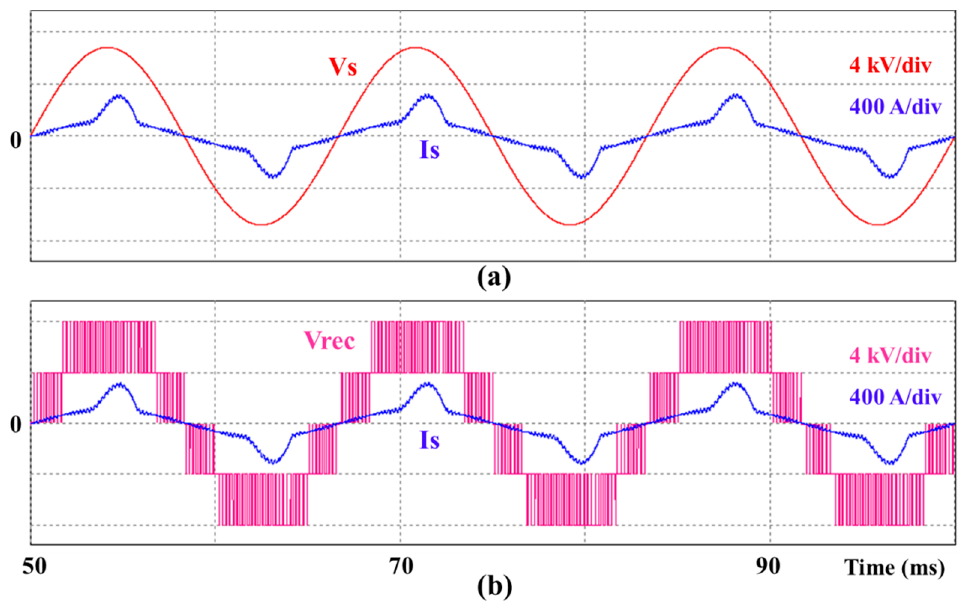
Figure 13. Simulation results for the five-level OCC MV Regen-Load waveforms with diode rectifier